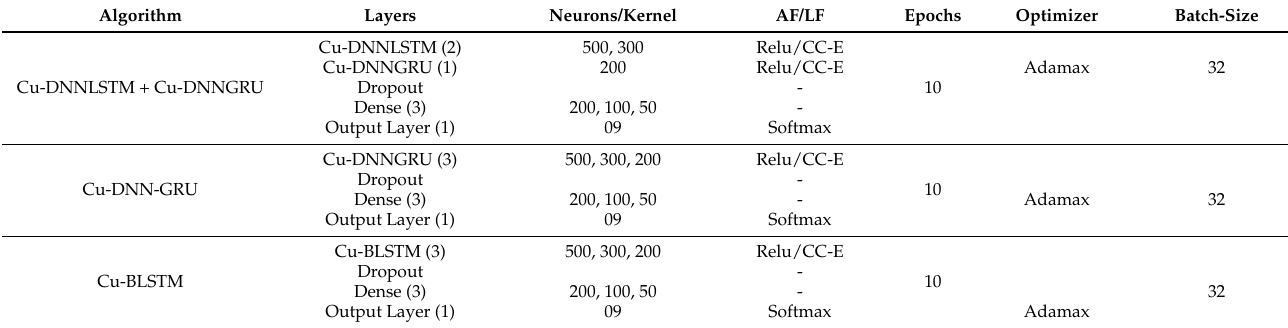
Table 1. Description of hybrid DL algorithms.